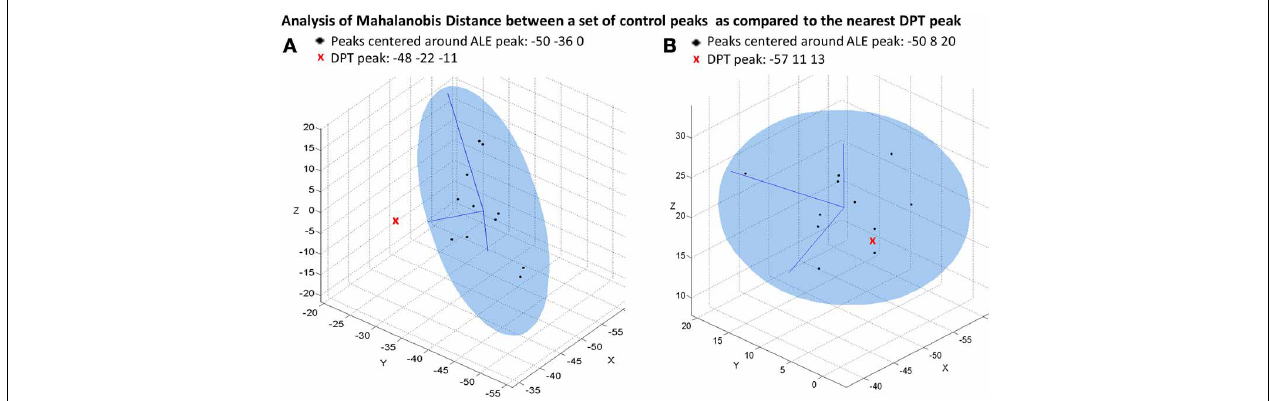
FIGURE 5 | Mahalanobis distance plots depicting peak activations for DPT and control participants. The ellipsoids represent the 95%